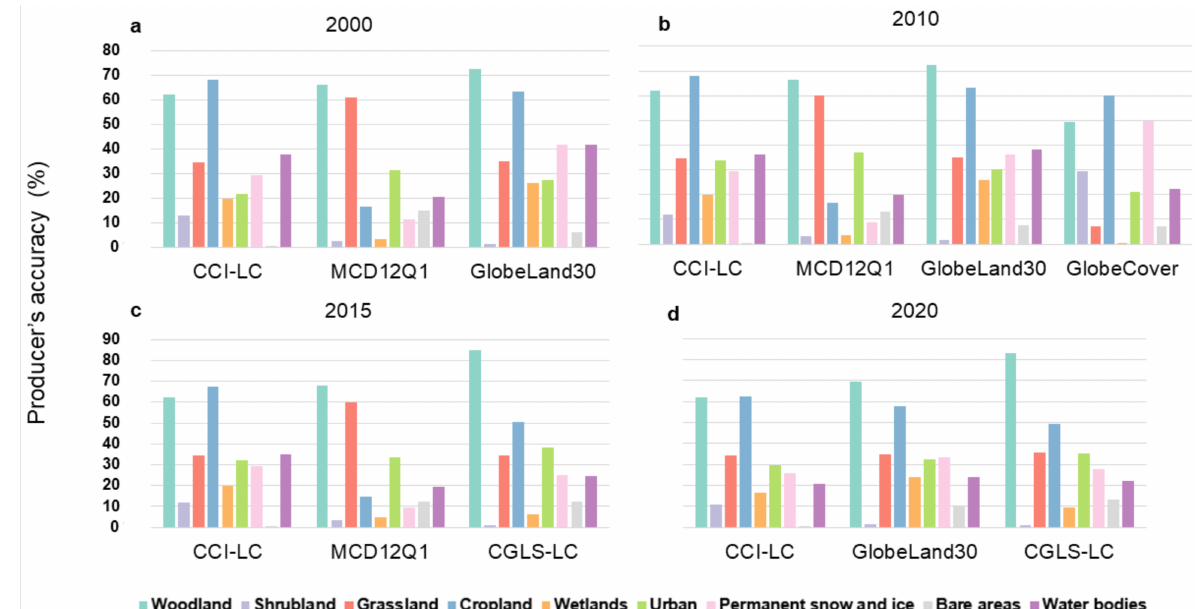
Figure 7. Producer’s accuracy for various LC datasets in epochs ( a ) 2000, ( b ) 2010, ( c ) 2015, and